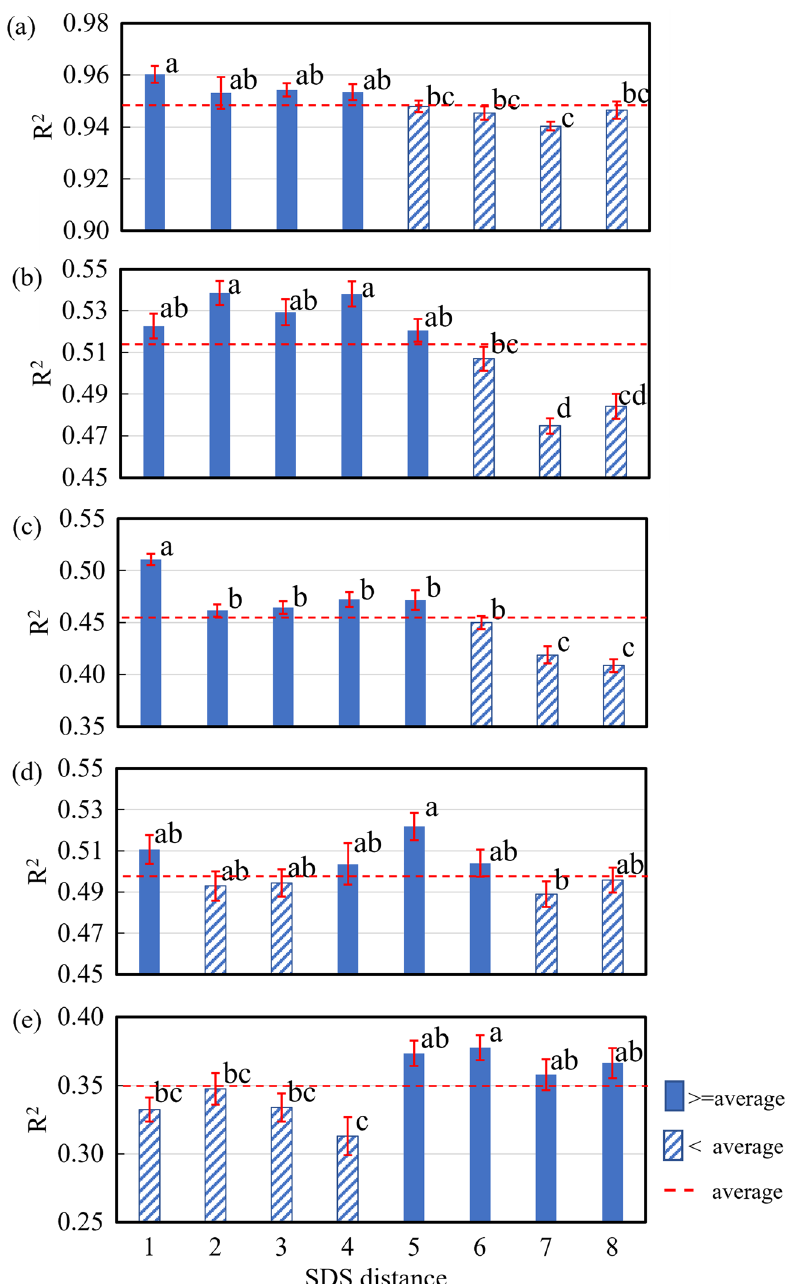
Figure 8. Average (± SE) R 2 for PLS models for skin ( a ) and individual fleshes at different depths [Flesh 1 ( b ), Flesh 2 ( c ), Flesh 3 ( d ), and Flesh 4 ( e )] based on interactances collected at different SDS distances. Significant differences were observed between certain SDS distances for both skin and fleshes at all depths, showing that the optimal SDS distance suited to estimate anthocyanin content in flesh at different depth may differ from one